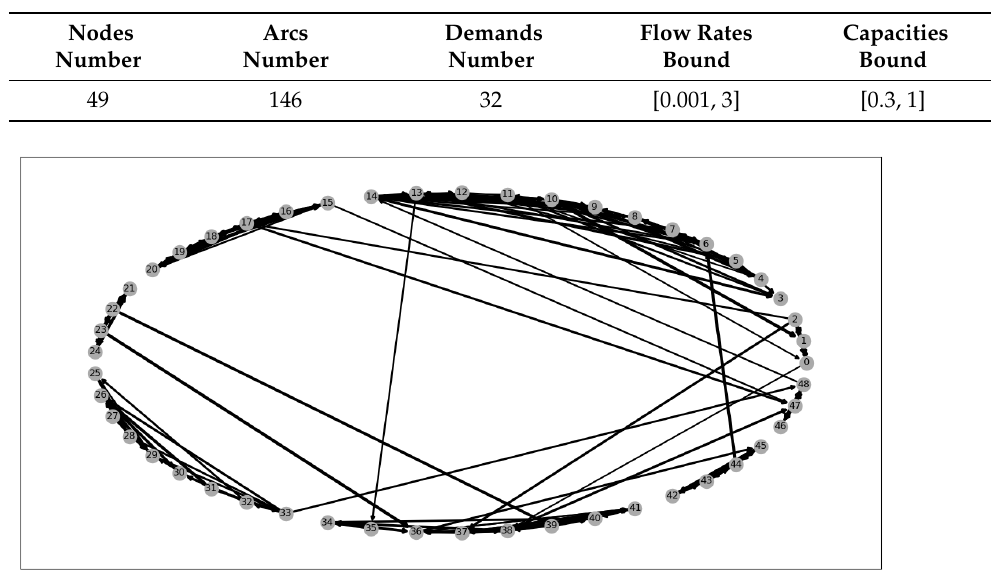
Table 2. Large problem instances’ parameters.